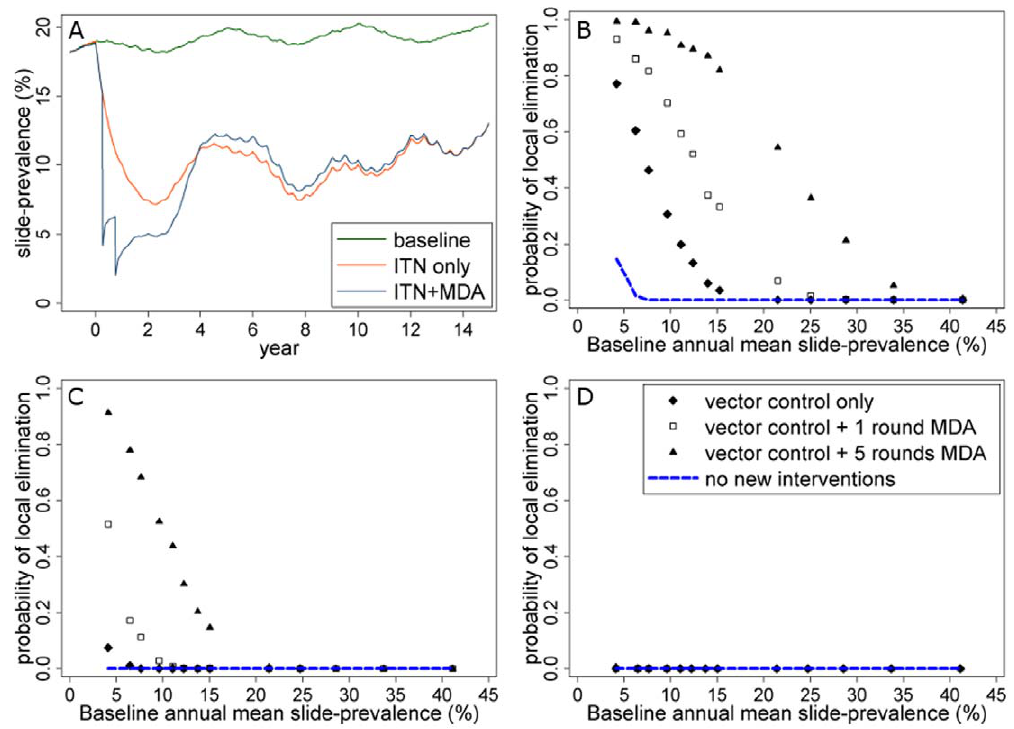
Figure 4. Model-estimated combined impact of MDA and vector control and the potential for elimination. (A) Vector control is scaled up in year 0, with or without 2 rounds of MDA during the first year. B), C) & D) Probabilities of local elimination in an isolated population of (B) 1000, (C) 10,000 or (D) 500,000 using vector control alone or in combination with MDA. Transmission is moderately seasonal and MDA is given prior to the transmission